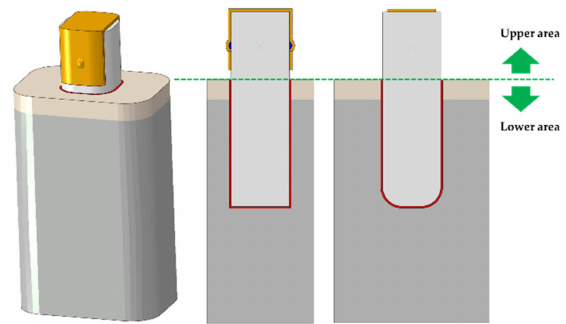
Figure 4. The teeth were separated into upper and lower regions based on the coronal position of PDL in order to analyze the displacement and rotation values of teeth according to various